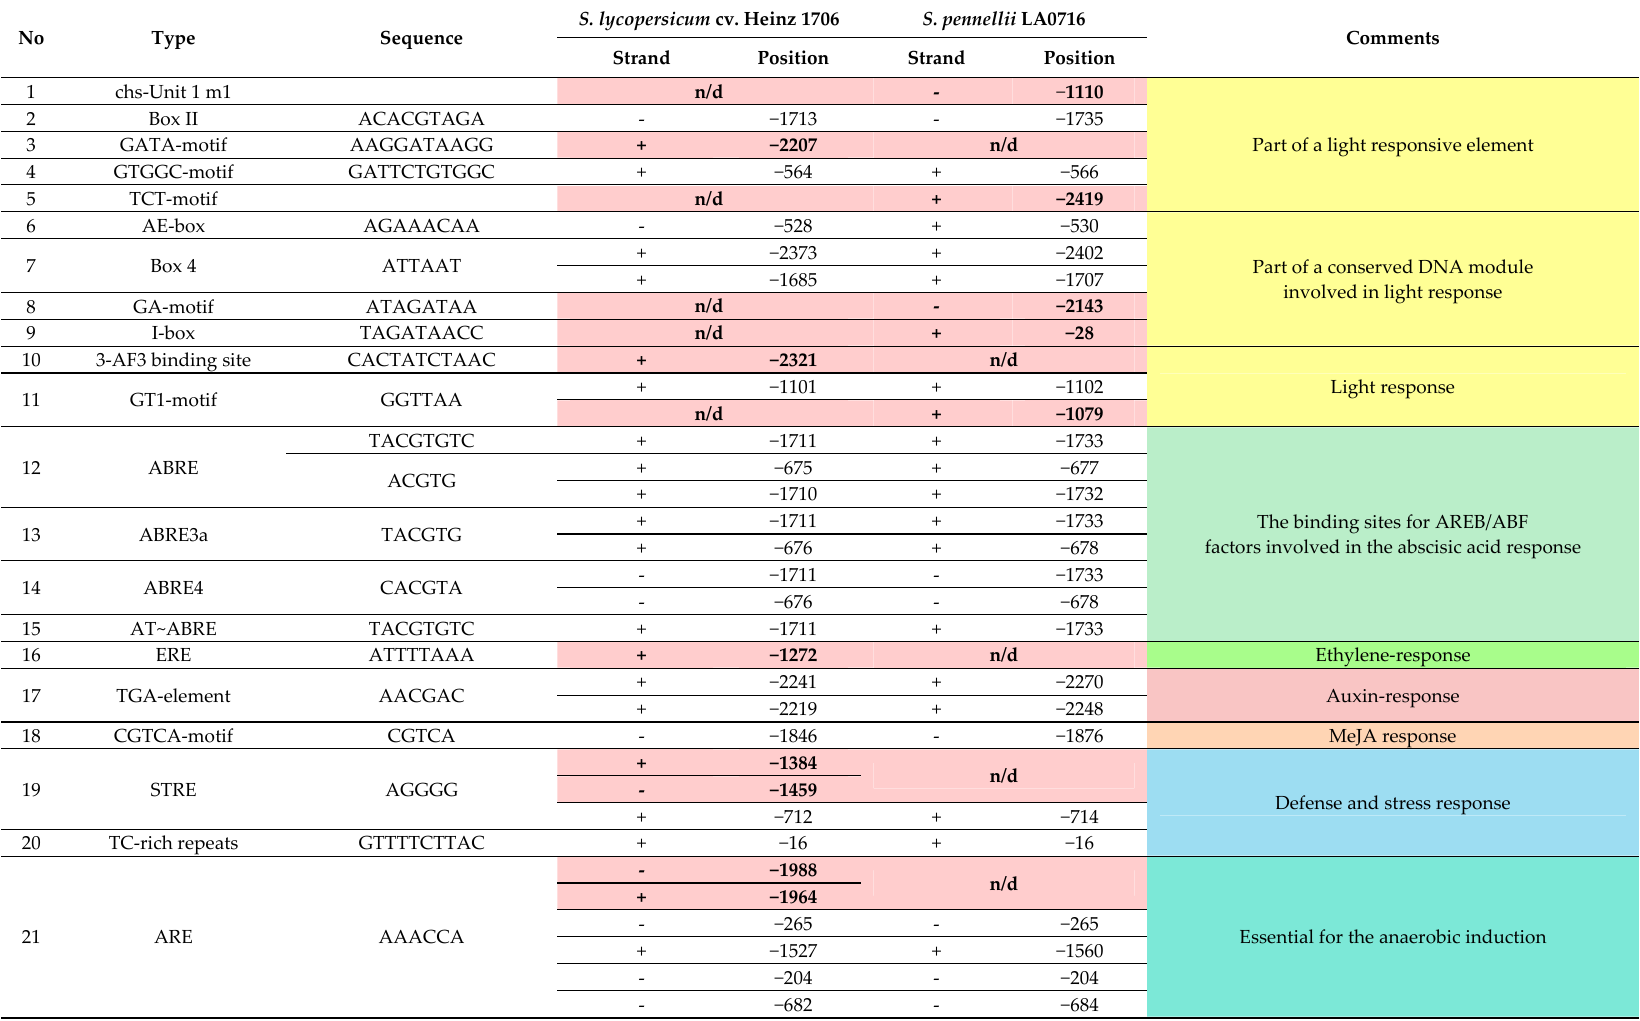
Table 3. Regulatory elements found in the PSY1 promoter and 5 ′ -UTR of RF S. lycopersicum and GF S. pennellii